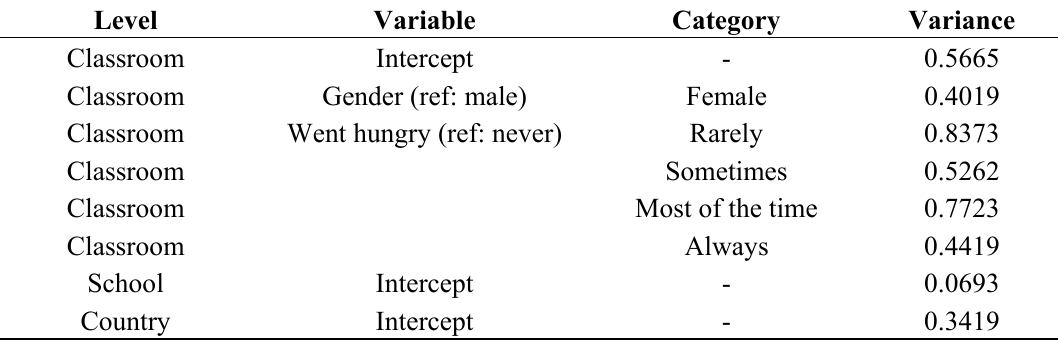
Table 5. Random effects model for variables that explain differences in bullying rates among 15 low- and middle income countries